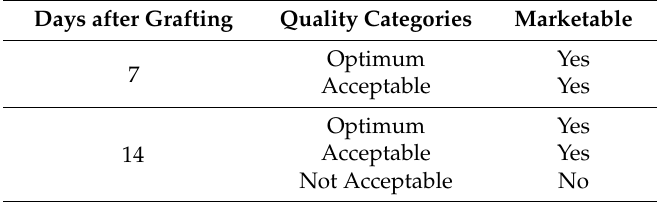
Table 1. Seedling quality categories derived seven and 14 days after grafting of watermelon seedlings. Days after Grafting Quality